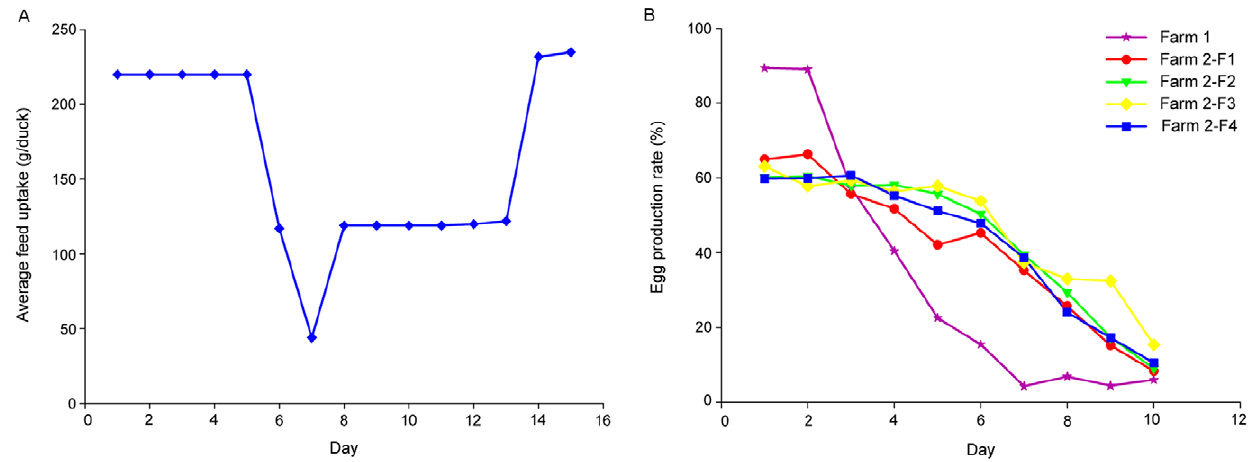
Figure 2. The course of natural disease. Representative of the average feed uptake of the infected flock at Farm 1 (A); Daily egg production rate represented by two infected duck farms (B). The flocks at Farm 1 were 35 weeks old, and Farm 2 flocks 1–4 (Farm 2-F1, -F2, F3, -F4) are four different flocks (76 weeks old) at another representative farm.